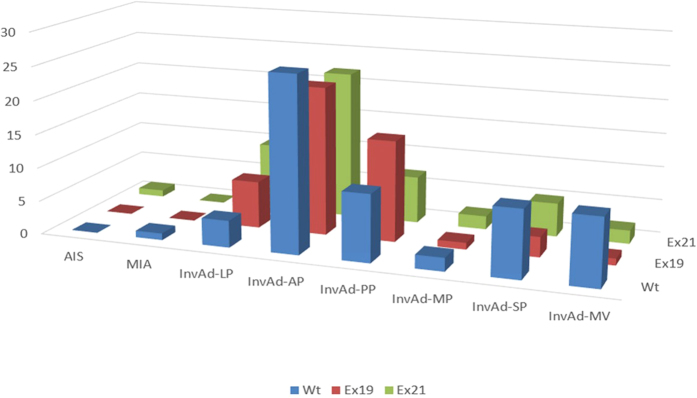
Number of each adenocarcinoma subtype (2011 IASLC/ATS/ERS classification) among the 3 EGFR statuses.